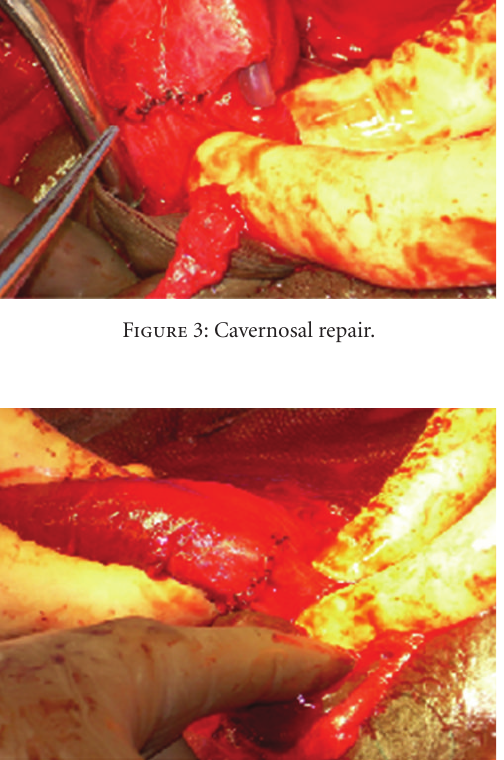
Figure 4: Completed